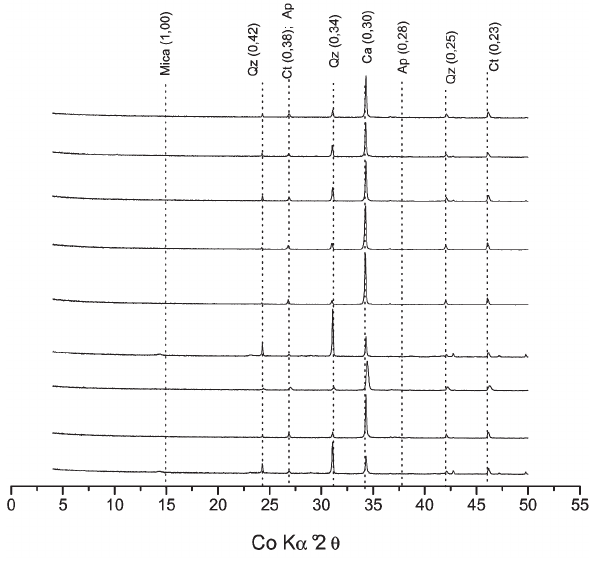
Figura 4. Difratogramas de raios-X da fração silte do solo da Lapa do Boquete. Qz: quartzo; mica; Ct: caulinita; Ca: calcita; e Ap: apatita.